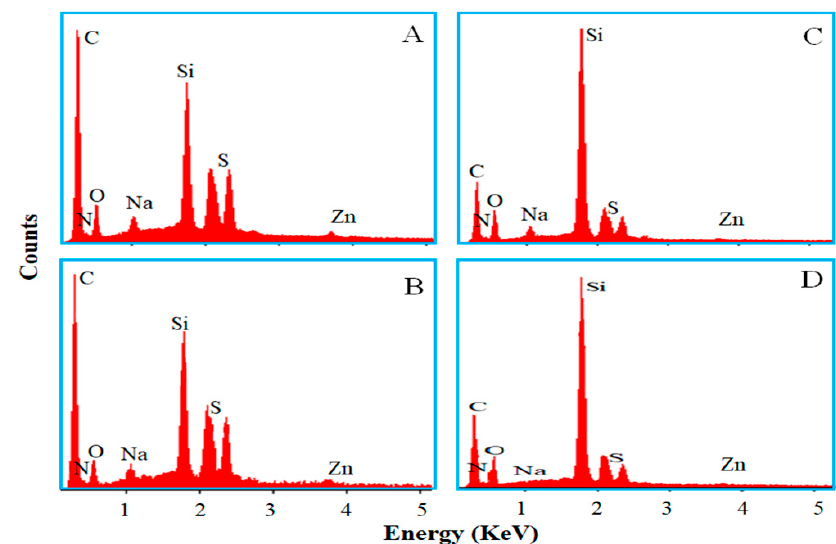
Figure 5. Energy-dispersive spectroscopy (EDS) spectra of the Si69- ( A and C ) and Si69/[EMIM]OAc- containing vulcanizates ( B and D ) at φ = 0.04 ( A and B ) and φ = 0.177 ( C and D ).